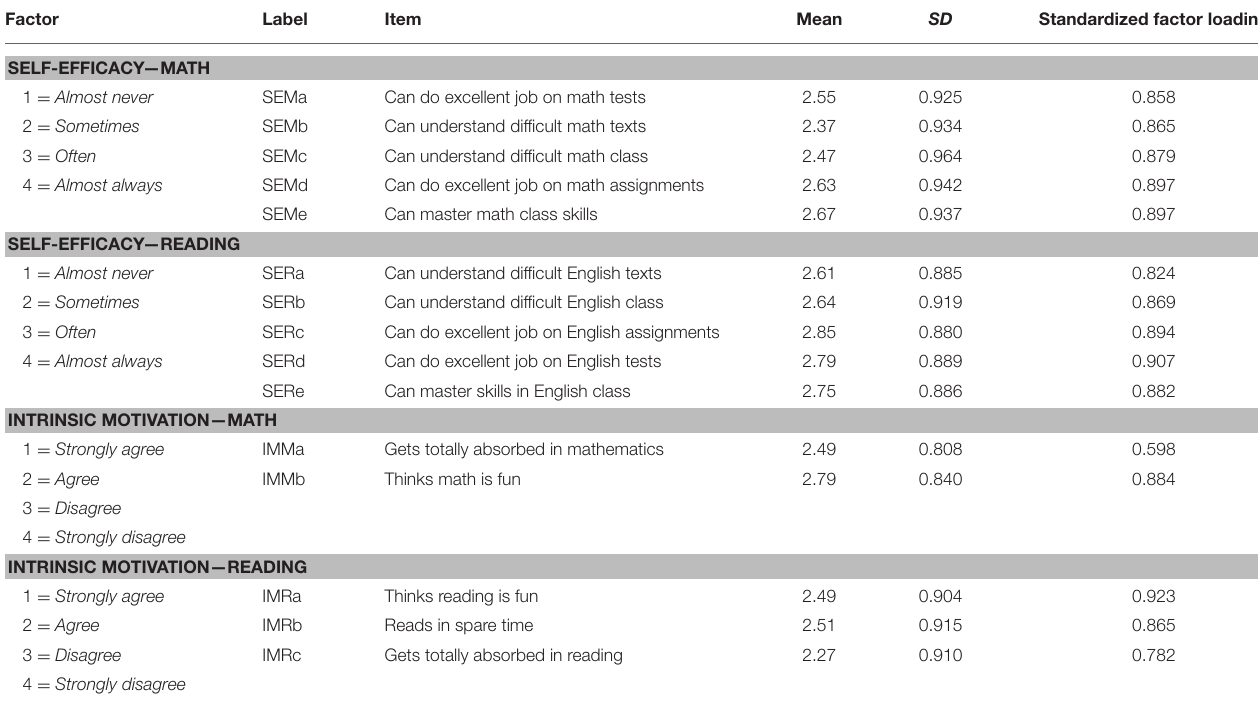
TABLE 2 | Student motivation items, means, standard deviations, and standardized factor loading. Factor Label Item Mean